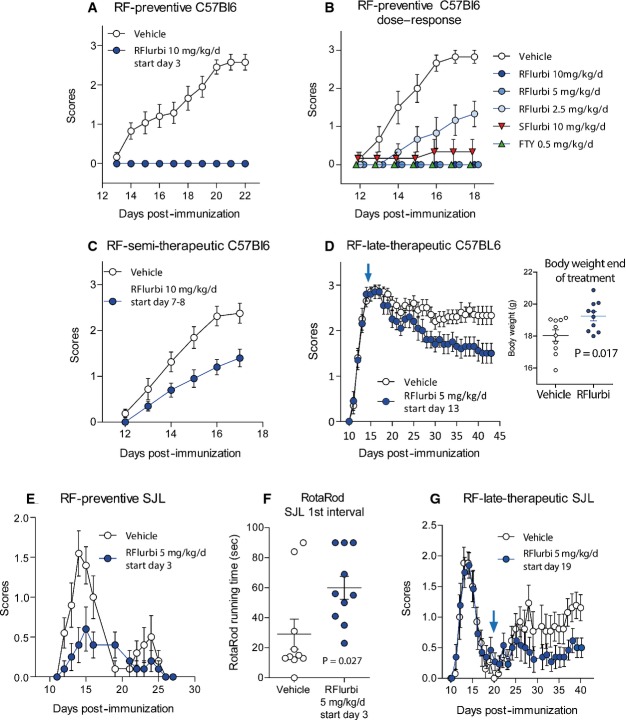
Attenuation of clinical EAE scores by R-flurbiprofenTime courses of the clinical scores (means ± SEM) in experimental autoimmune encephalomyelitis (EAE) models in C57BL6/J mice (A–D) and SJL/J mice (E–G) treated with vehicle versus R-flurbiprofen. C57BL6/J mice develop a primary progressive EAE (PP-EAE) and SJL/J a relapsing-remitting RR-EAE. Scores: Score 0, no obvious changes in motor functions; score 0.5, distal paralysis of the tail; score 1, complete tail paralysis; score 1.5, mild paresis of one or both hind legs; score 2, severe paresis of hind legs; score 2.5, complete paralysis of one hind leg; score 3, complete paralysis of both hind legs; score 3.5, complete paralysis of hind legs and paresis of one front leg.
EAE scores in C57BL6/J mice on preventive treatment with R-flurbiprofen (10 mg/kg/day) or vehicle. Treatment started 3 days after immunization and was continuously administered in the drinking water (n = 12 per group, rm-ANOVA for ‘treatment’ P = 3.691E-8).Dose response of EAE scores in C57BL6/J mice treated from 3 days after immunization with vehicle, R-flurbiprofen (2.5, 5, and 10 mg/kg/day), S-flurbiprofen (10 mg/kg/day) and FTY720 (0.5 mg/kg/day), all continuously administered in the drinking water (n = 6 per group, rm-ANOVA for ‘treatment’ with Dunnett post hoc versus vehicle, P < 0.0001 for all treatment groups and time points ≥ 14 days after immunization).EAE scores in C57BL6/J mice on semi-therapeutic treatment with R-flurbiprofen (10 mg/kg/day) or vehicle. Treatment started 3–4 days before onset of clinical scores, that is, 7–8 after immunization. (n = 10 per group, rm-ANOVA for ‘treatment’ P = 0.0085).EAE scores in C57BL6/J mice on late-therapeutic treatment with R-flurbiprofen (5 mg/kg/day) or vehicle. Treatment started after full development of the disease 13 days after immunization (the arrow indicates the start of treatment). Animals were allocated as score-matched pairs to the vehicle or R-flurbiprofen group. R-flurbiprofen or vehicle was administered via drug or vehicle soaked sweet cornflakes (n = 10 per group, rm-ANOVA for ‘time × treatment’ Greenhouse-Geisser adjusted, P = 0.008). The insert in (D) shows the mean body weight of the last 3 treatment days (n = 10 per group, two-sided unpaired Student's t-test, P = 0.017).EAE scores on preventive treatment with R-flurbiprofen (5 mg/kg/day) or vehicle. Treatment started 3 days after immunization and was continuously administered in the drinking water (n = 10 per group, rm-ANOVA for ‘treatment’, P = 0.0034).Running time in the Rota Rod test during the 1st interval in SJL mice treated with vehicle or R-flurbiprofen from day 3 onwards (5 mg/kg/day) (n = 10, unpaired two-sided Student's t-test, P = 0.027).EAE scores in SJL mice on late-therapeutic treatment with R-flurbiprofen (5 mg/kg/day) or vehicle. Treatment started on day 19, that is, after the first disease flare (arrow indicates the start). Animals were allocated to the treatment groups as score-matched pairs based on the severity of the first flare of the disease. Only mice with scores ≥ 1 were included, namely, 70% of all mice (n = 13 for the treatment period, n = 20 were immunized, rm-ANOVA for ‘time × treatment’, P = 0.0125).